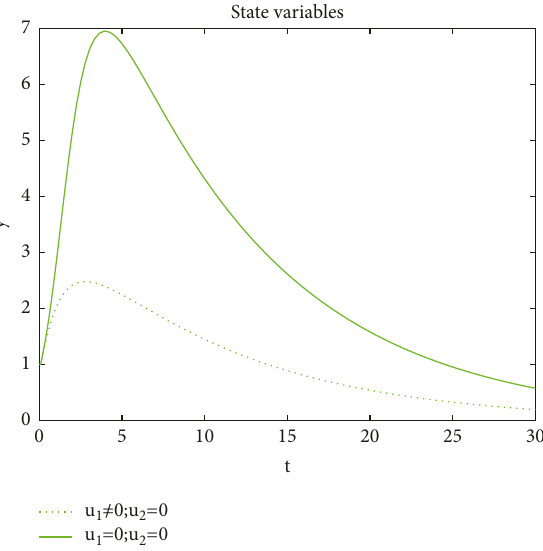
Figure 2: Evolution of number of 𝑦(𝑡) with or without control.